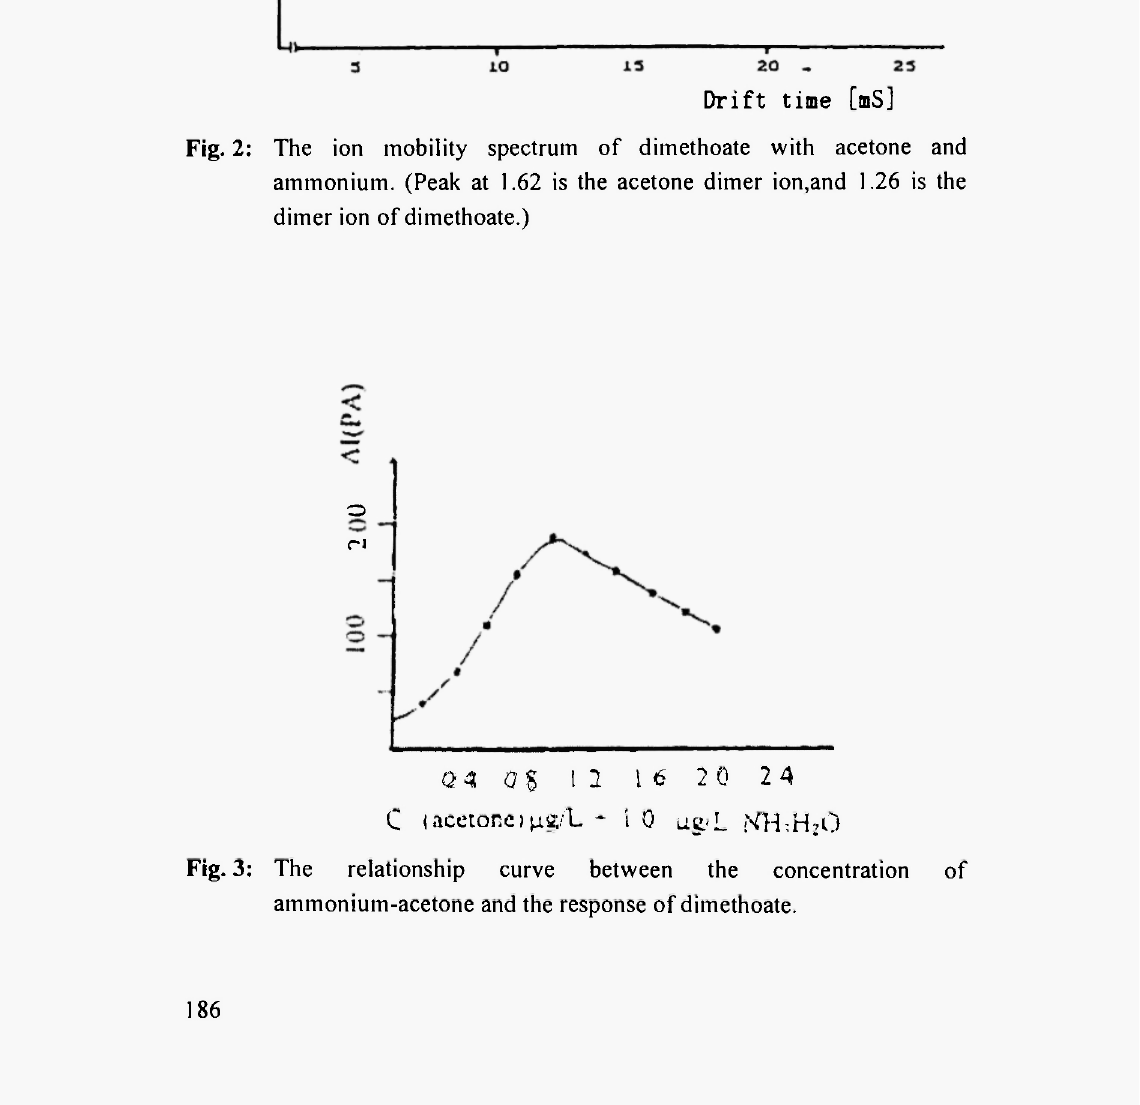
Fig. 3: The relationship curve between the concentration ammonium-acetone and the response of dimethoate.